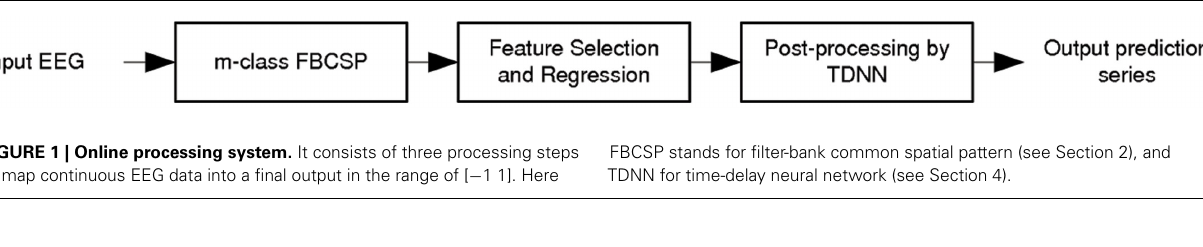
FIGURE 1 | Online processing system. It consists of three processing steps to map continuous EEG data into a final output in the range of [ − 1 1]. Here